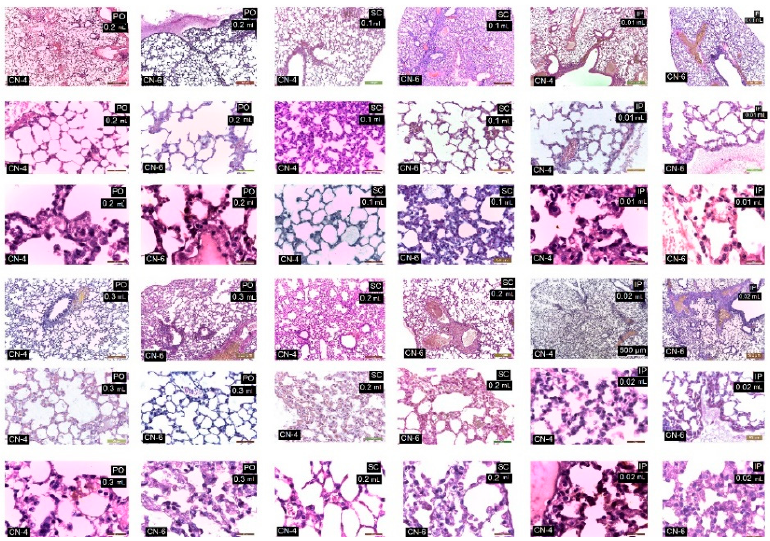
Figure 13. Lungs in the experimental group. HE staining.